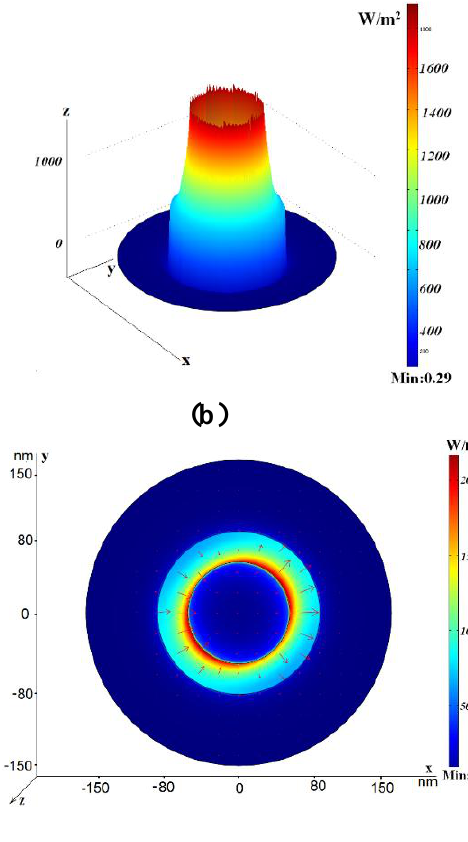
= 2.61 + i 0.36, L = 1.1  eff